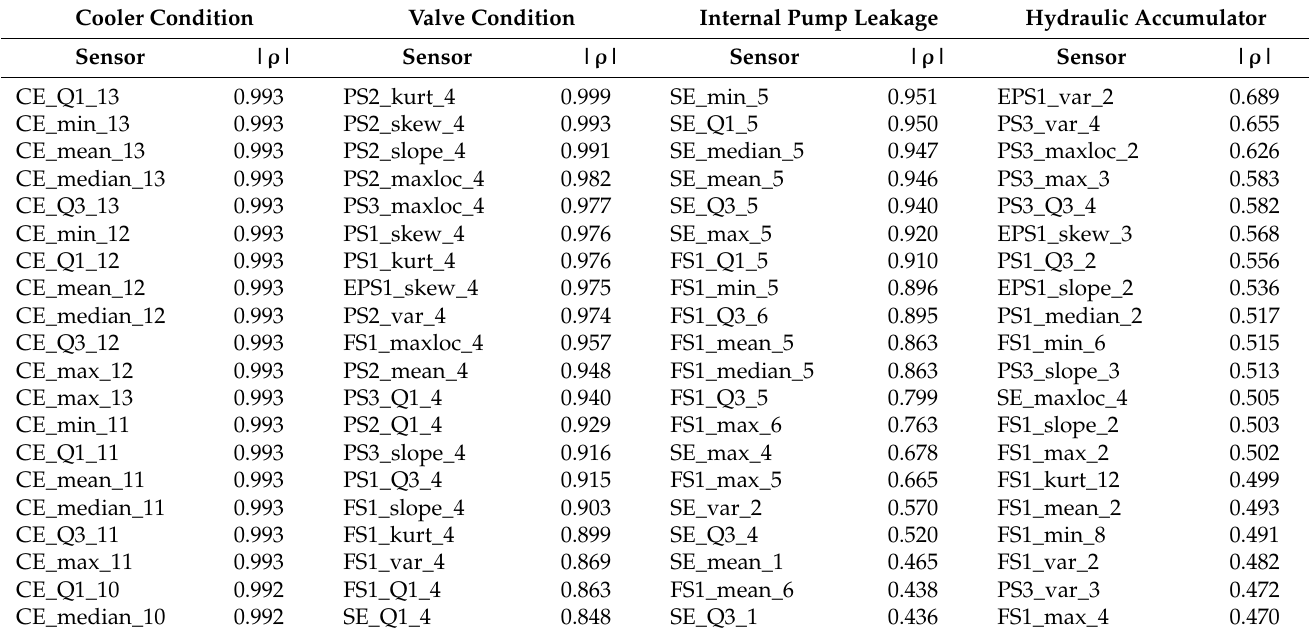
Table 4. Feature selection through Pearson correlation